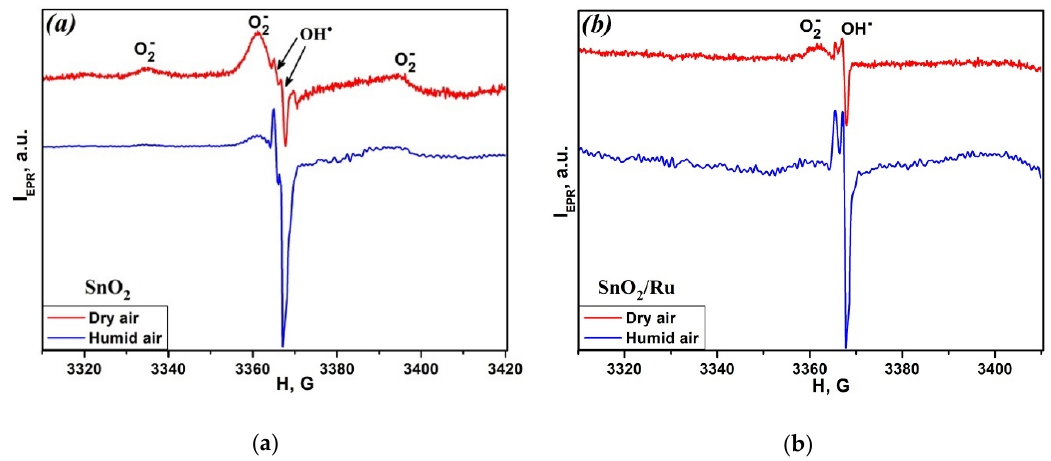
Figure 4. Electron paramagnetic resonance (EPR) spectra of SnO 2 ( a ) and SnO 2 / Ru ( b ) in dry air and after exposure to humid air.